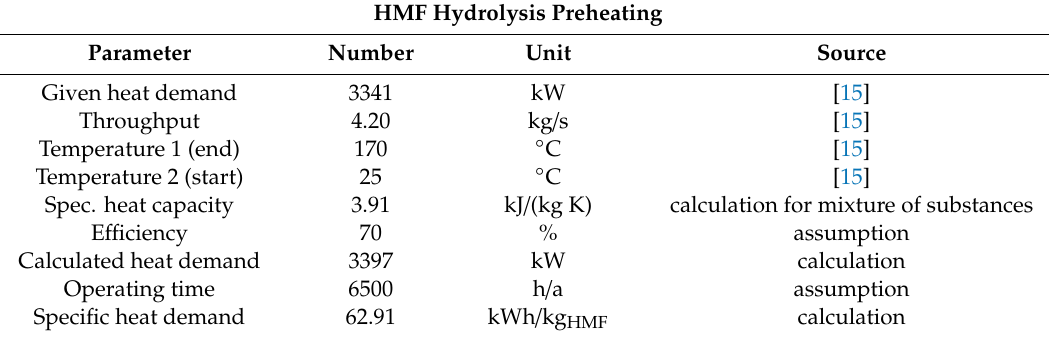
Table 2. Example for verifying the power requirement and calculating the specific energy requirement of a given process